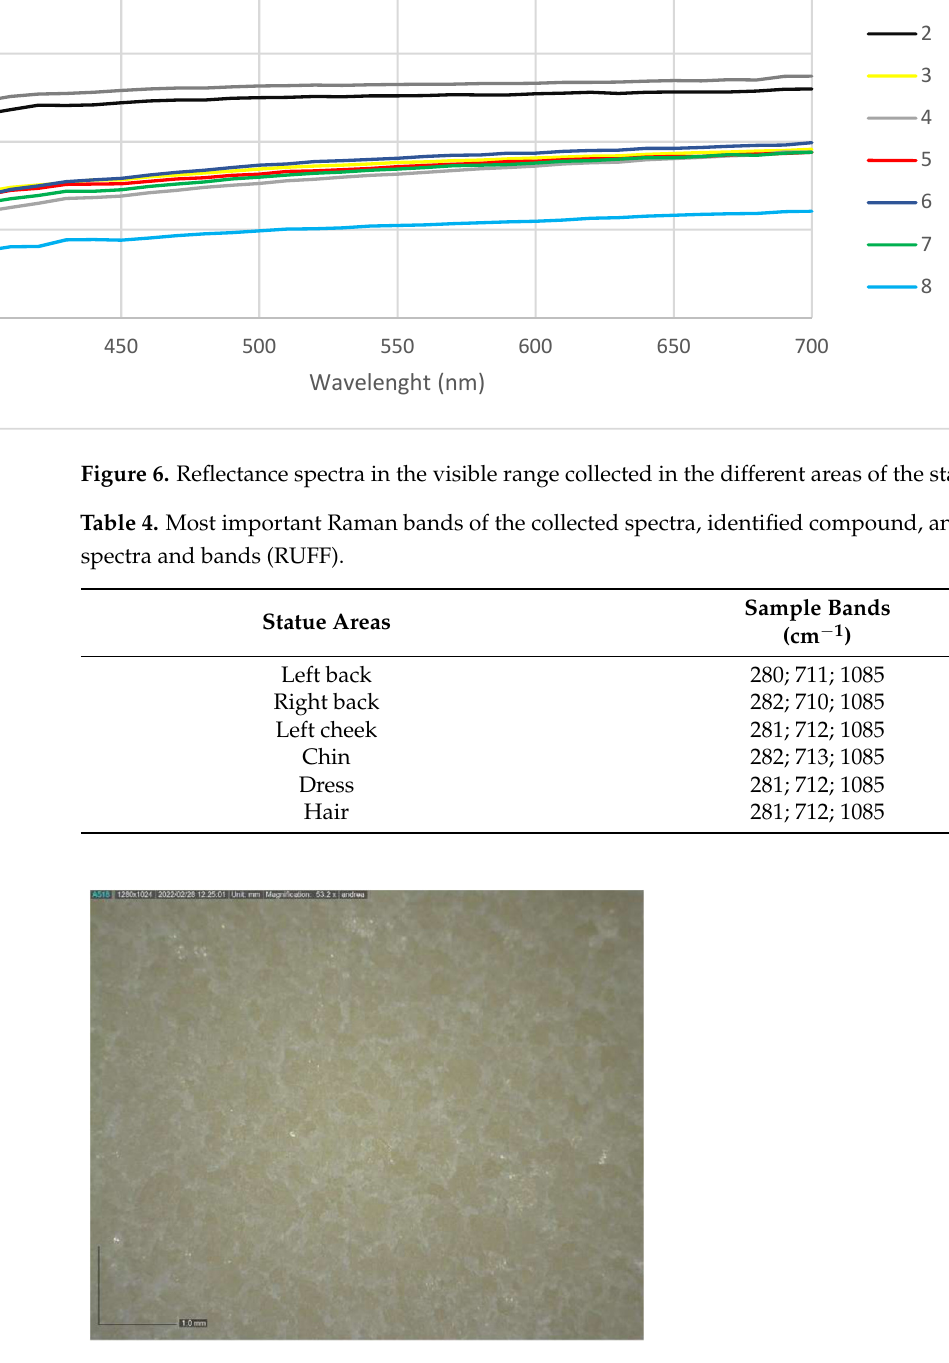
Figure 7. Image at 53.2 × magnification of the surface.